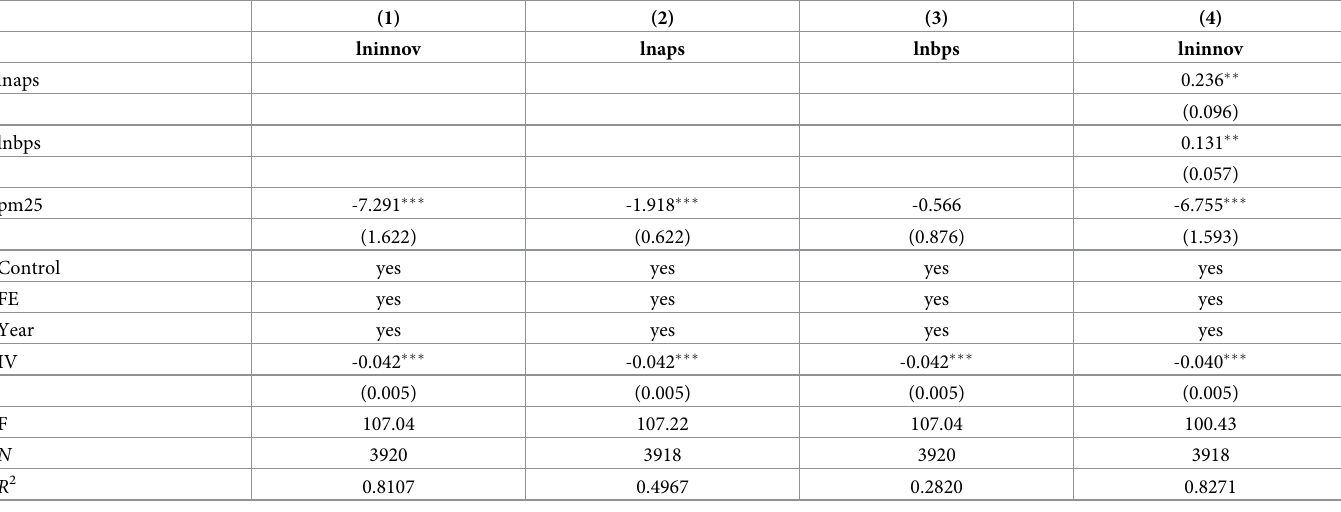
Table 11. Advanced productor services and basic productor services.